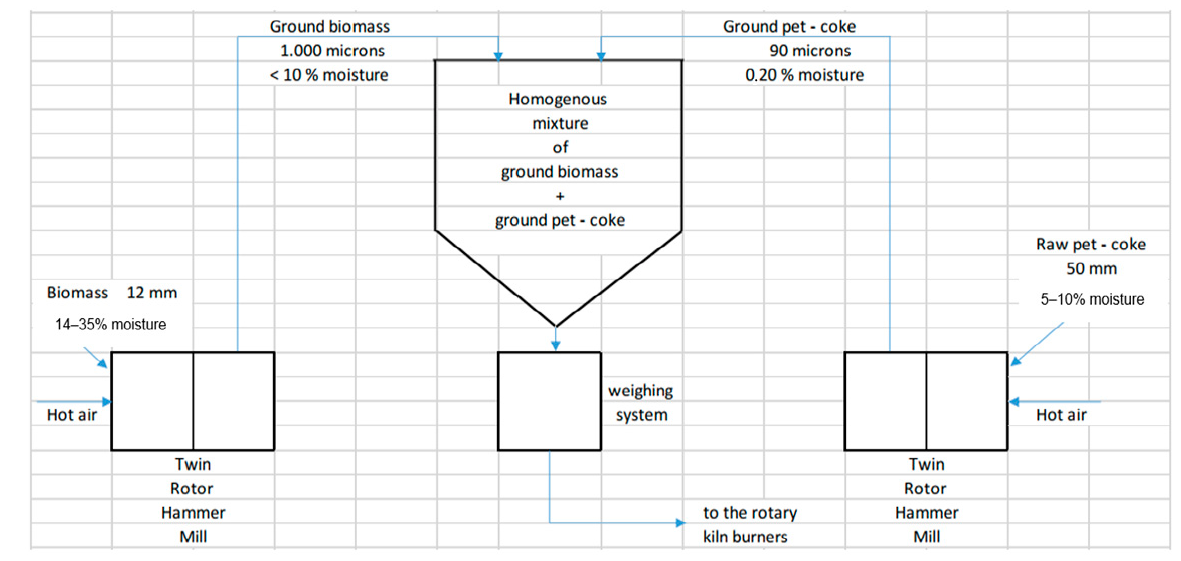
Figure 3. Biomass at GM: Co-firing mode.